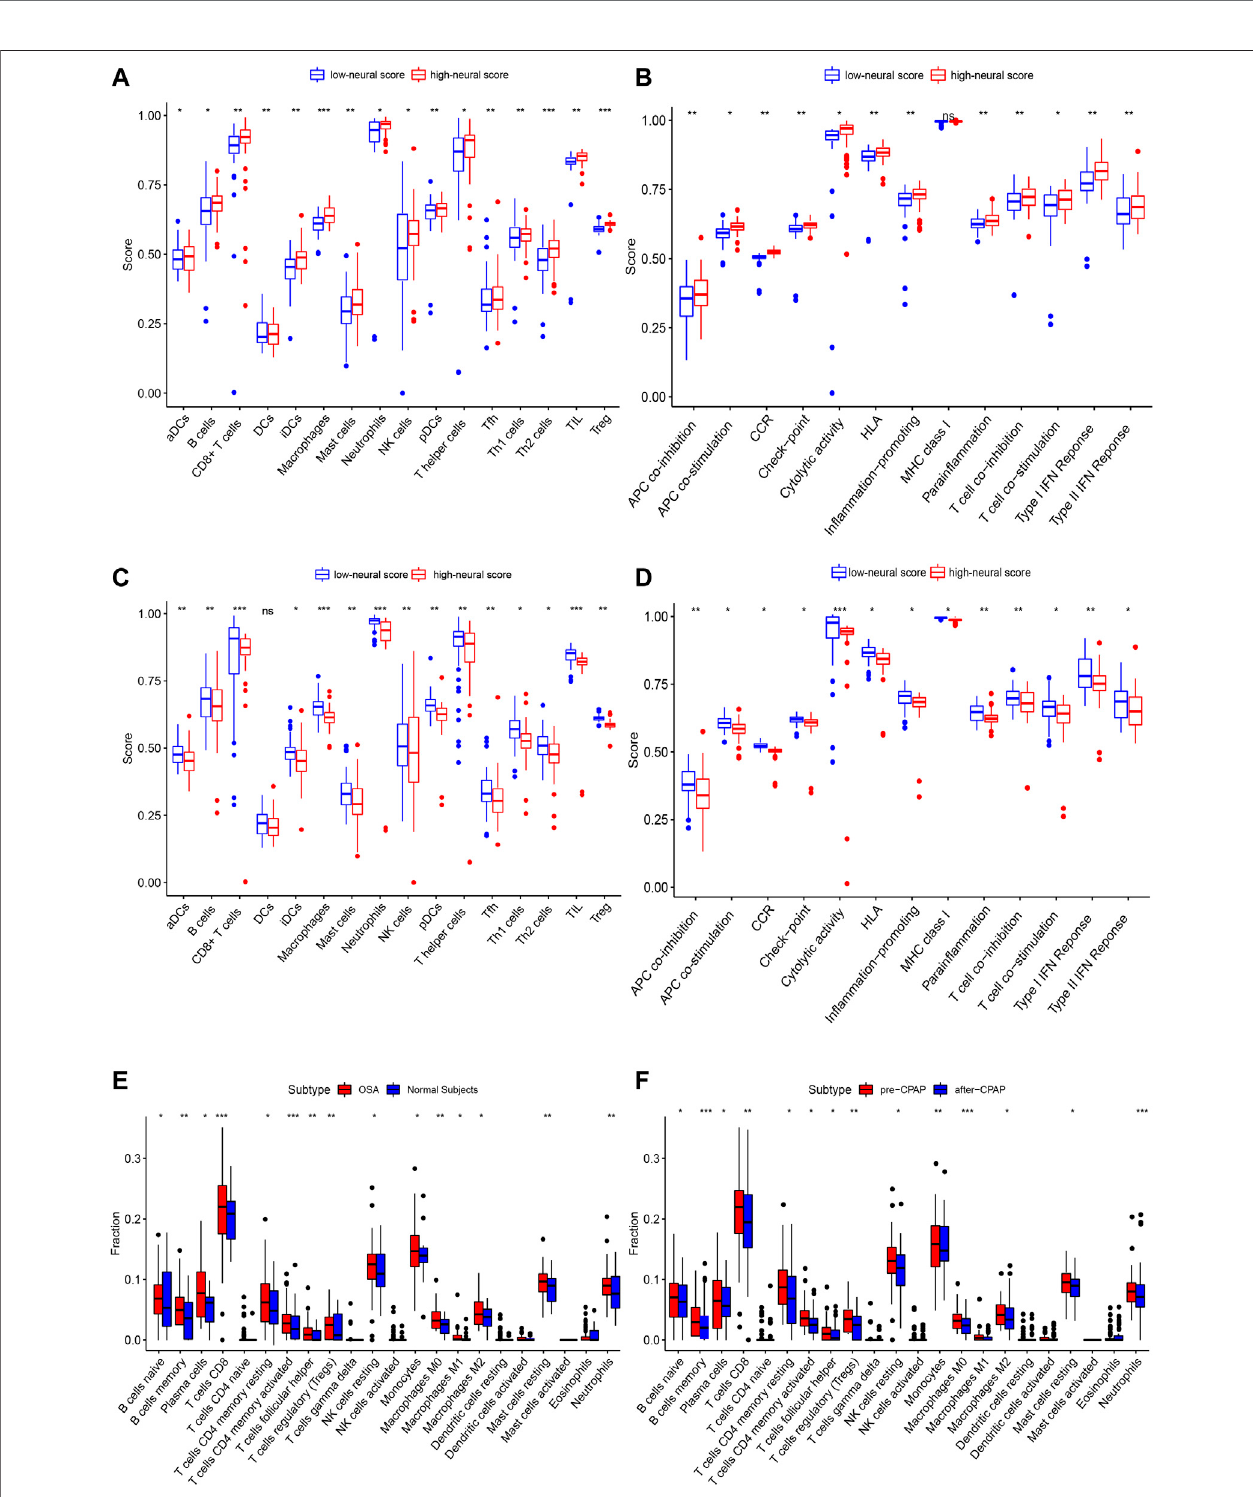
FIGURE 8 | The enrichment levels of 28 immune-related cells and functions in the ssGSEA results for the ANN model. (A,B) Other than MHC class I, all other immune terms in the ssGSEA were increased in the high neural score group, suggesting that OSA is associated with increased in fl ammation. (C,D) In addition to DCs, other immune-related terms in ssGSEA decreased after CPAP treatment, suggesting that CPAP could reduce the level of in fl ammation in OSA patients. (E,F) CIBERSORTanalysisofimmunecellfractionsofsamplesfromOSAandCPAPcohorts.PatientswithOSAhadhigher levelsofin fl ammation inmultipleimmunecell components, which decreased with CPAP use. *, p < 0.05; **, p < 0.01; ***, p < 0.001.